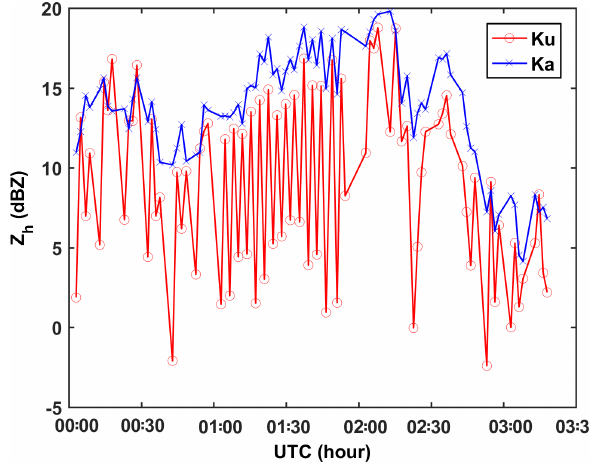
Figure 8. The time series of averaged raw Z h at the CARE site. There are two problems indicated in this figure: (i) the Ku-band Z h is smaller than the Ka-band Z h on average. (ii) Compared with the Ka-band, there are many too small values of the Ku-band Z h